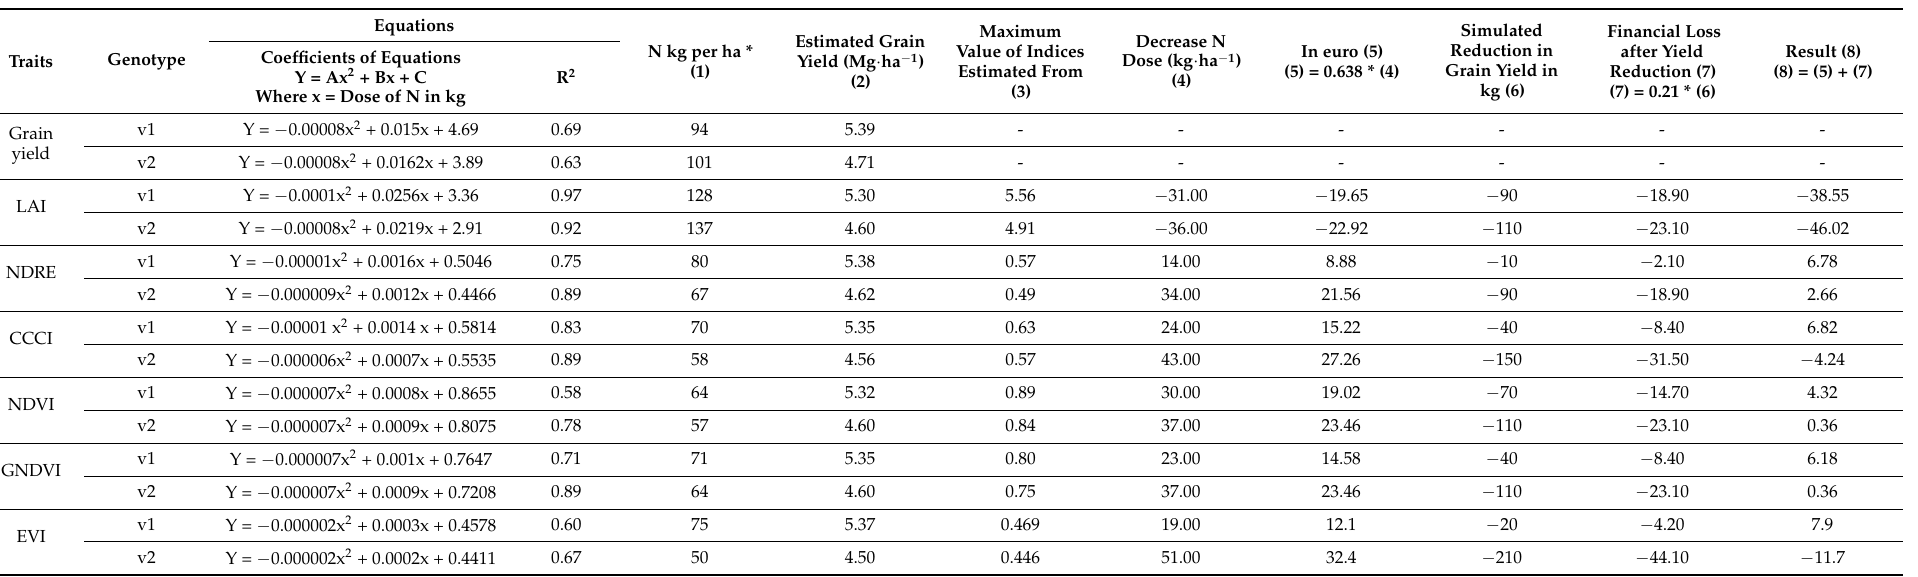
Table 10. Comparison of maximum of nitrogen dose, as well as value of indices calculated for grain yield and vegetation indices of hypoallergenic genotypes of winter